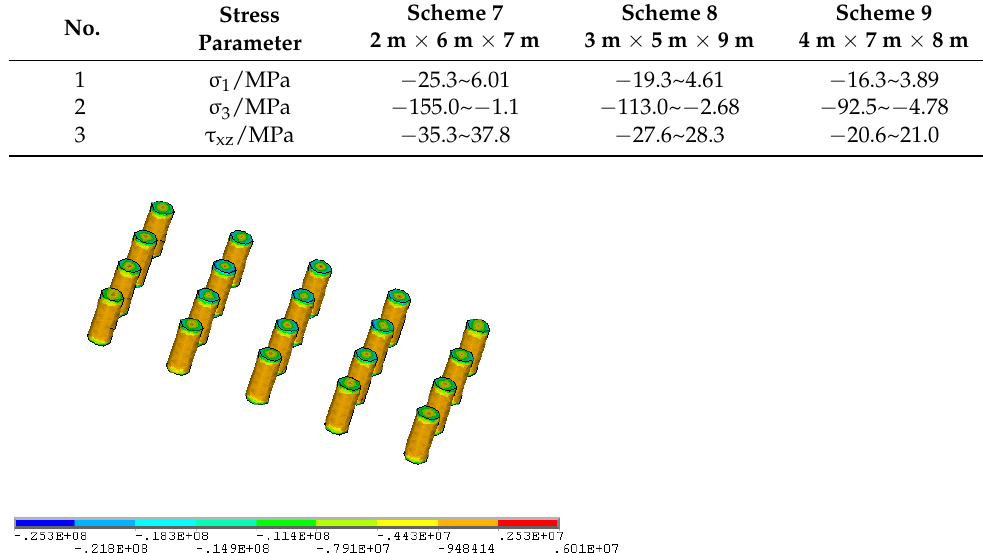
scheme 7: stope height 4.5 m, pillar diameter 2 m, pillar spacing 6 m, pillar row spacing 7